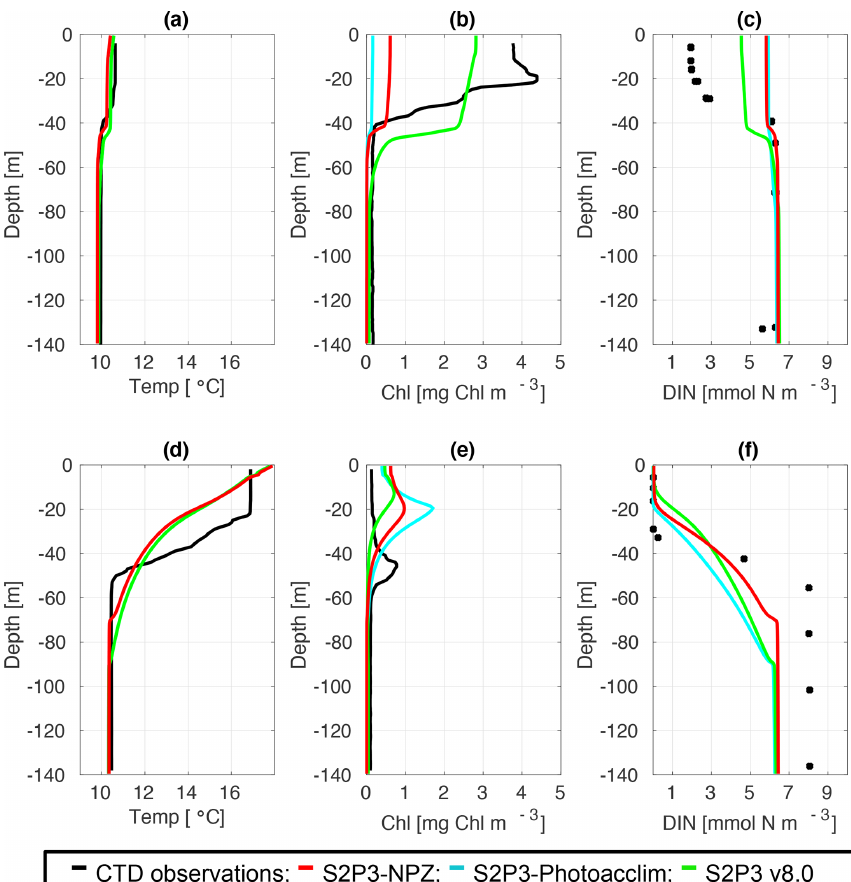
Figure 4. CTD observations from the SSB programme (black lines) including data for springtime (20 April 2015) (a) temperature, (b) chloro- phyll a , and (c) DIN (black dots); for summertime (24 July 2015) (d) temperature, (e) chlorophyll a , and (f) DIN (black dots) along the S2P3-NPZ (red line), S2P3-Photoacclim (cyan line), and S2P3 v8.0 (green line) calibrated